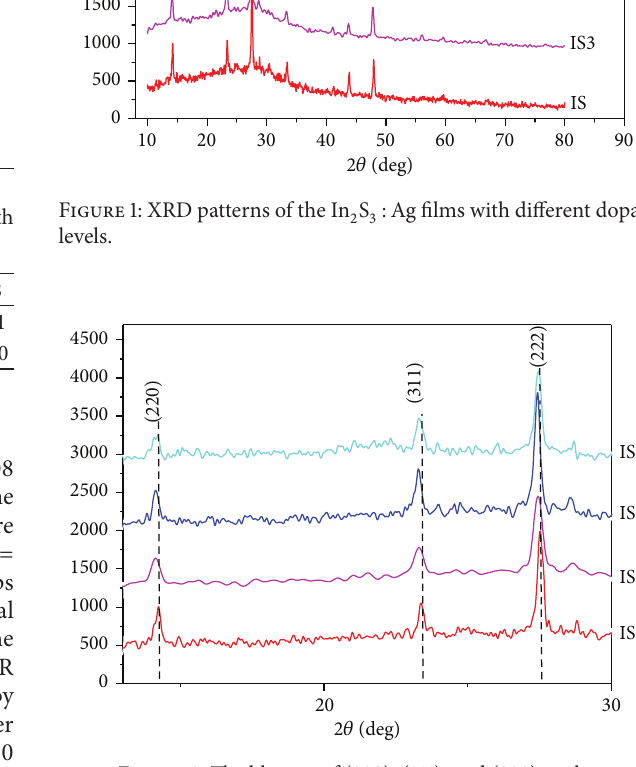
Figure 2: The blowup of (220), (311), and (222) peaks.